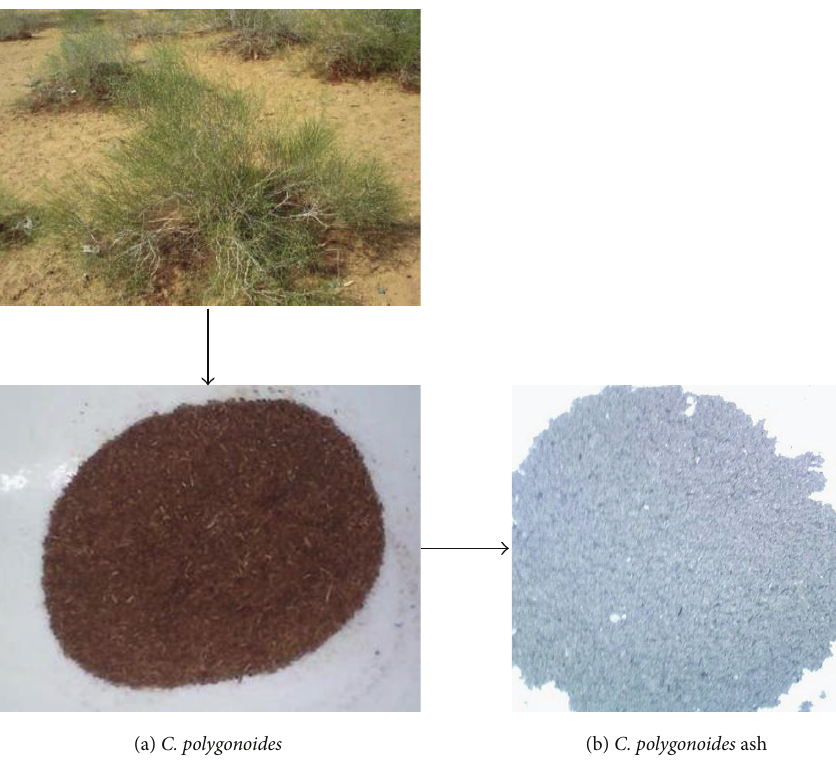
Figure 1: Digital photographs of C. polygonoides and its